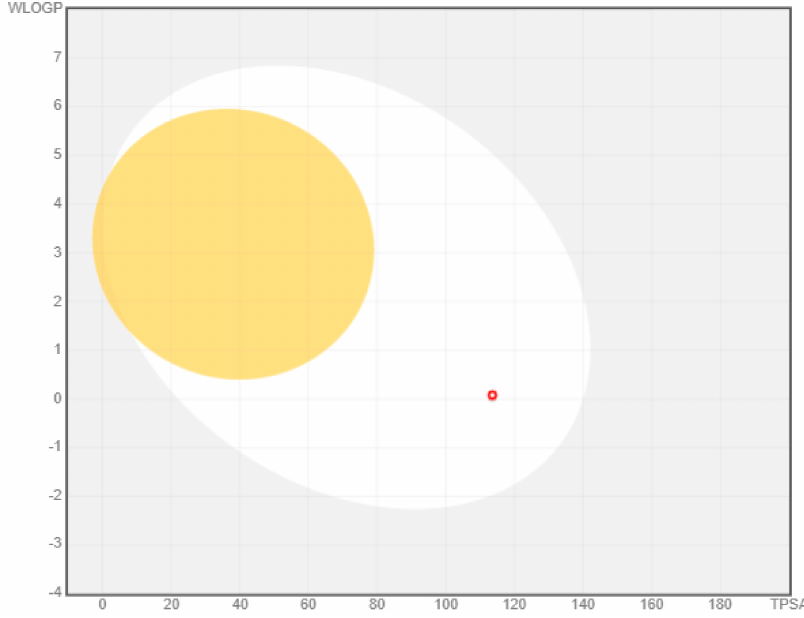
Figure 8. Pharmacokinetics bioled egg model. Yellow colour represents blood brain barrier (BBB), while colour represents gastrointestinal absorption for the selected drugs. Red circle represents compound 12